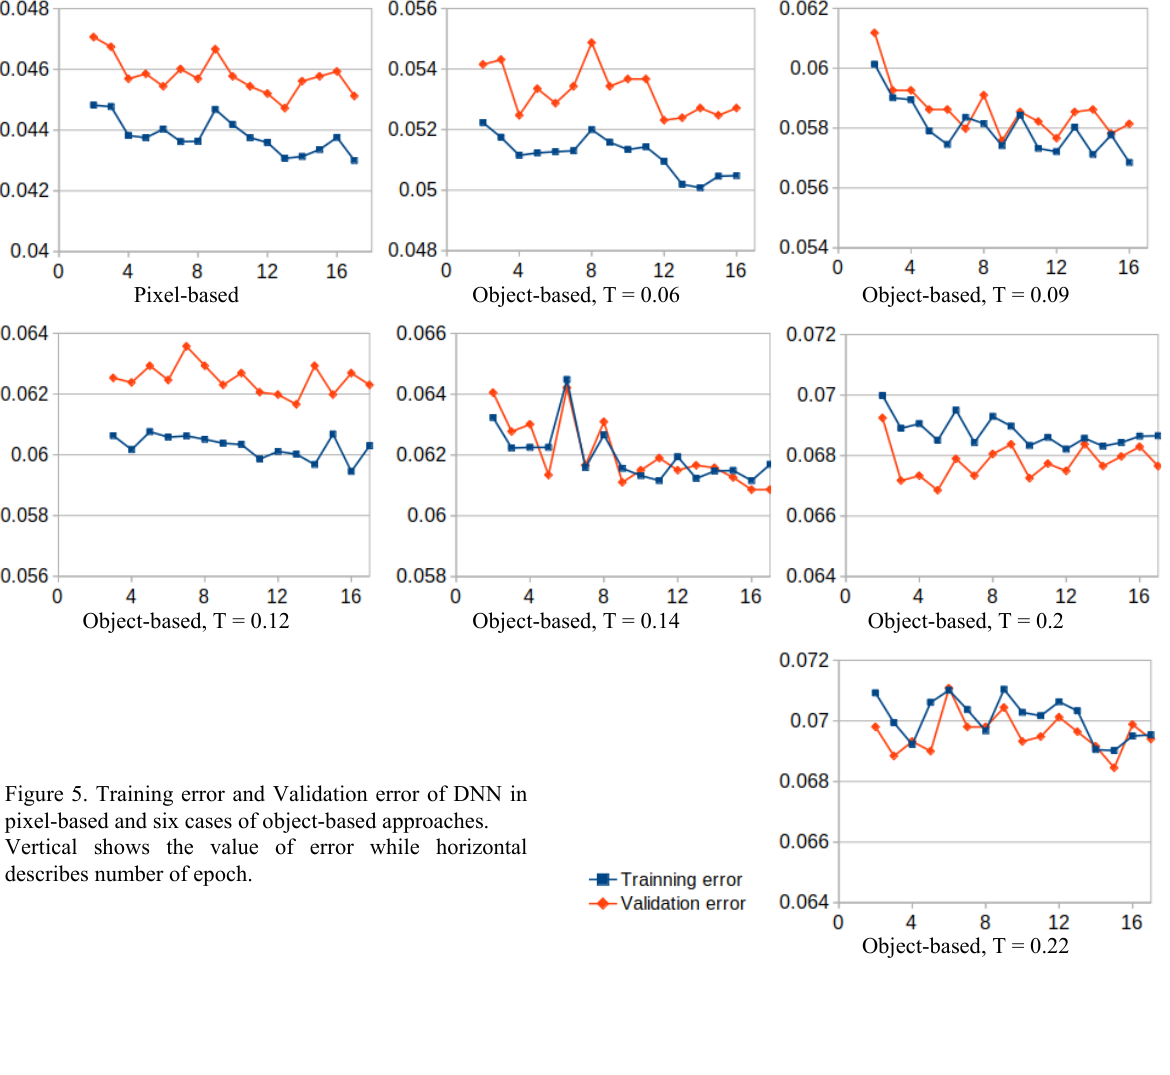
Figure 5. Training error and Validation error of DNN in pixel-based and six cases of object-based approaches. Vertical shows the value of error while horizontal describes number of